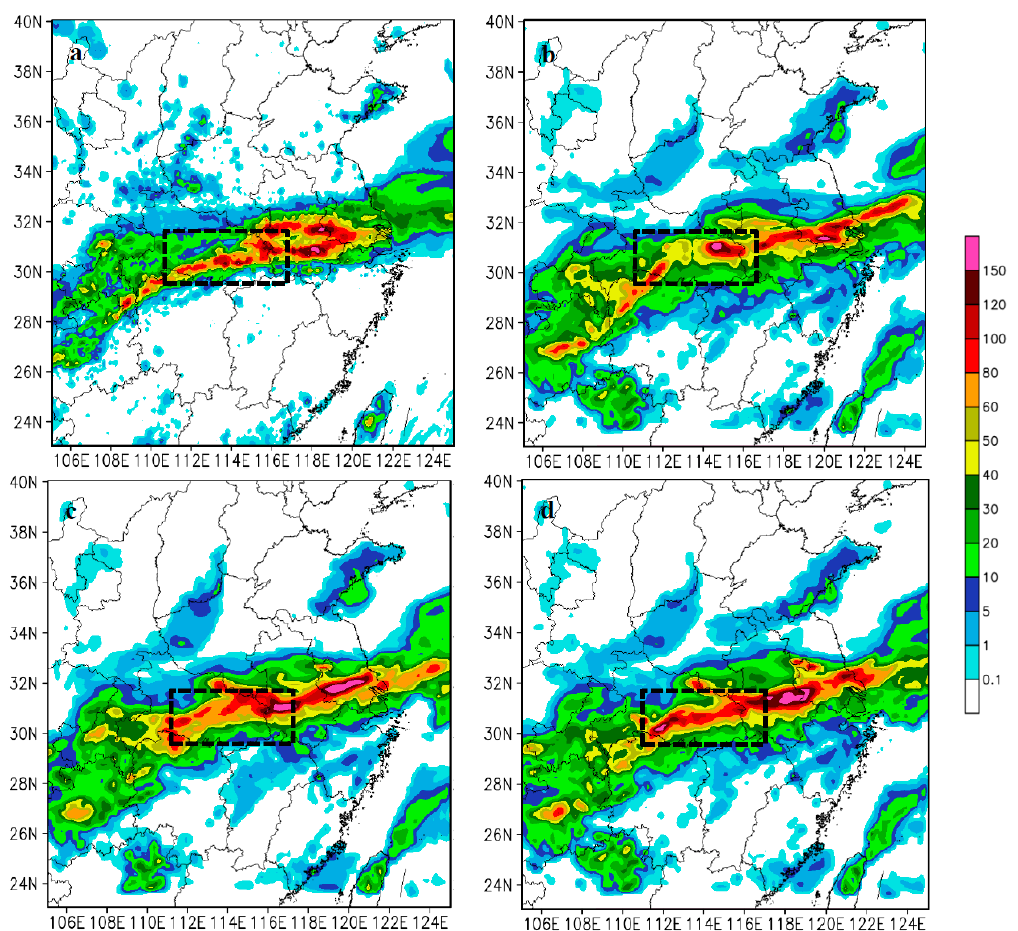
Figure 11. Twenty four-hour-accumulated rainfall of ( a ) observations, ( b ) conv4dvar, ( c ) pcp4dvar, and ( d ) convpcp4dvar initialized at 0600 UTC 05 July 2013.